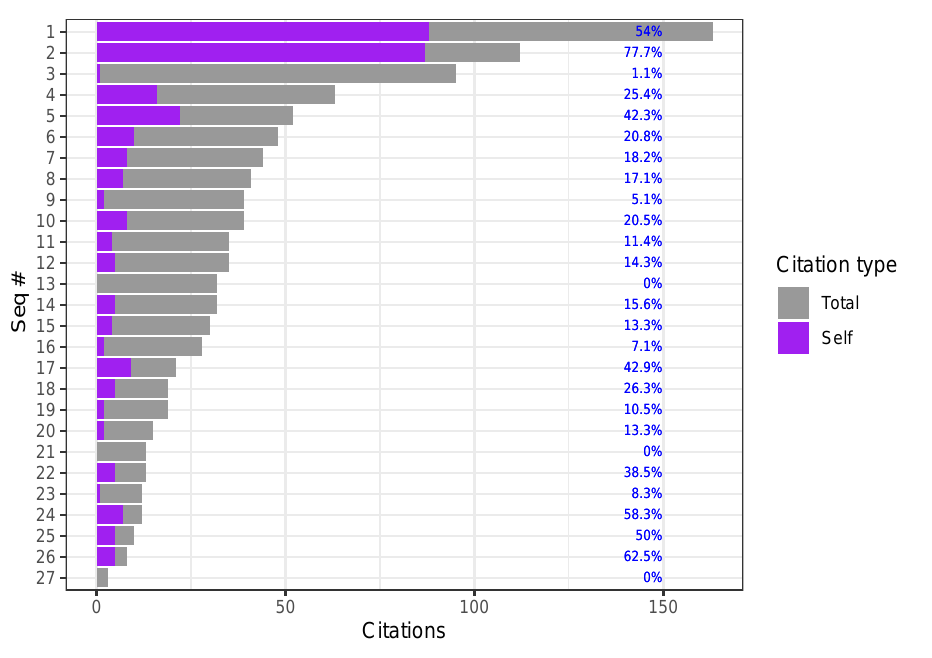
Figure 5. Self citations as a fraction of total citations after 5